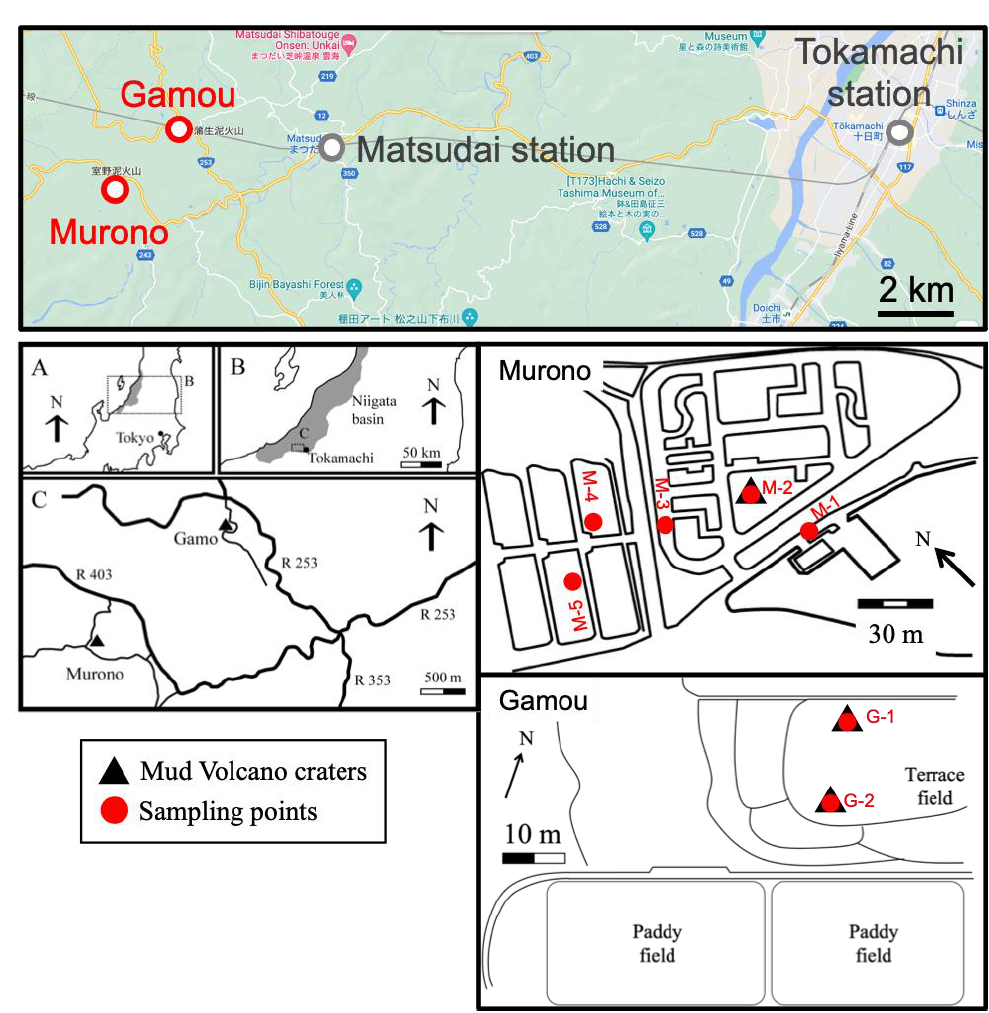
Figure 1. Maps of the Tokamachi area including 2 sampling sites (Murono and Gamou). Samples were taken from mud volcano craters (black triangles) as well as seeping points. Sampling points are indicated as red circles. The upper map is a screenshot from Google Maps accessed on 8th July 2022.